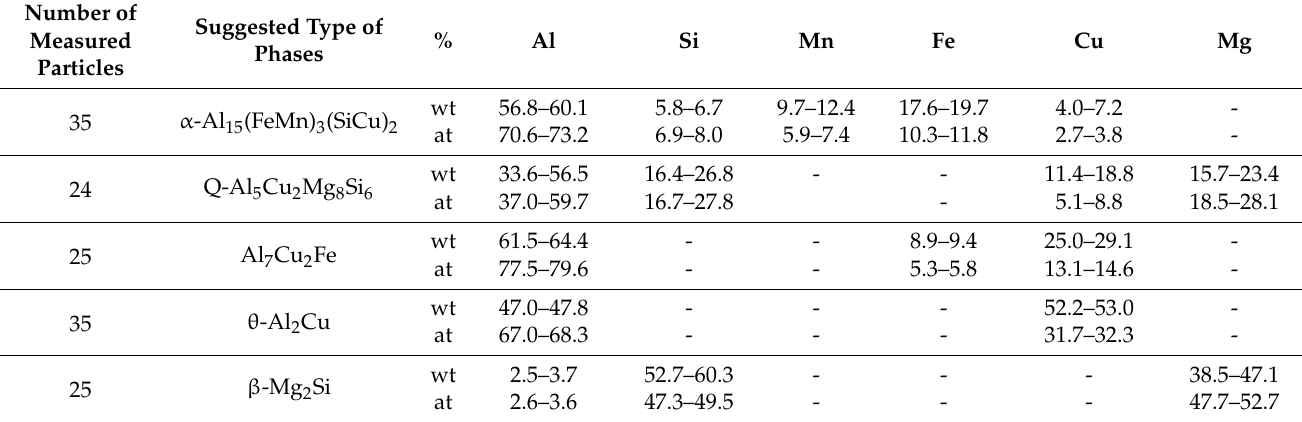
Table 3. Chemical composition of intermetallic phase particles (determined using SEM/EDS) in the as-cast 2017A alloy. Number of Measured Particles